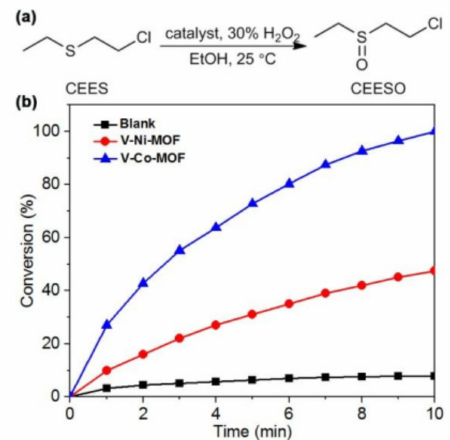
Figure 12. ( a ) Oxidation of CEES to CEESO catalysed by V–Ni–MOF and V–Co–MOF; ( b ) Time profile for the conversion of CEES using V–Ni–MOF, V–Co–MOF as catalysts and blank run. Reproduced with permission from [53].